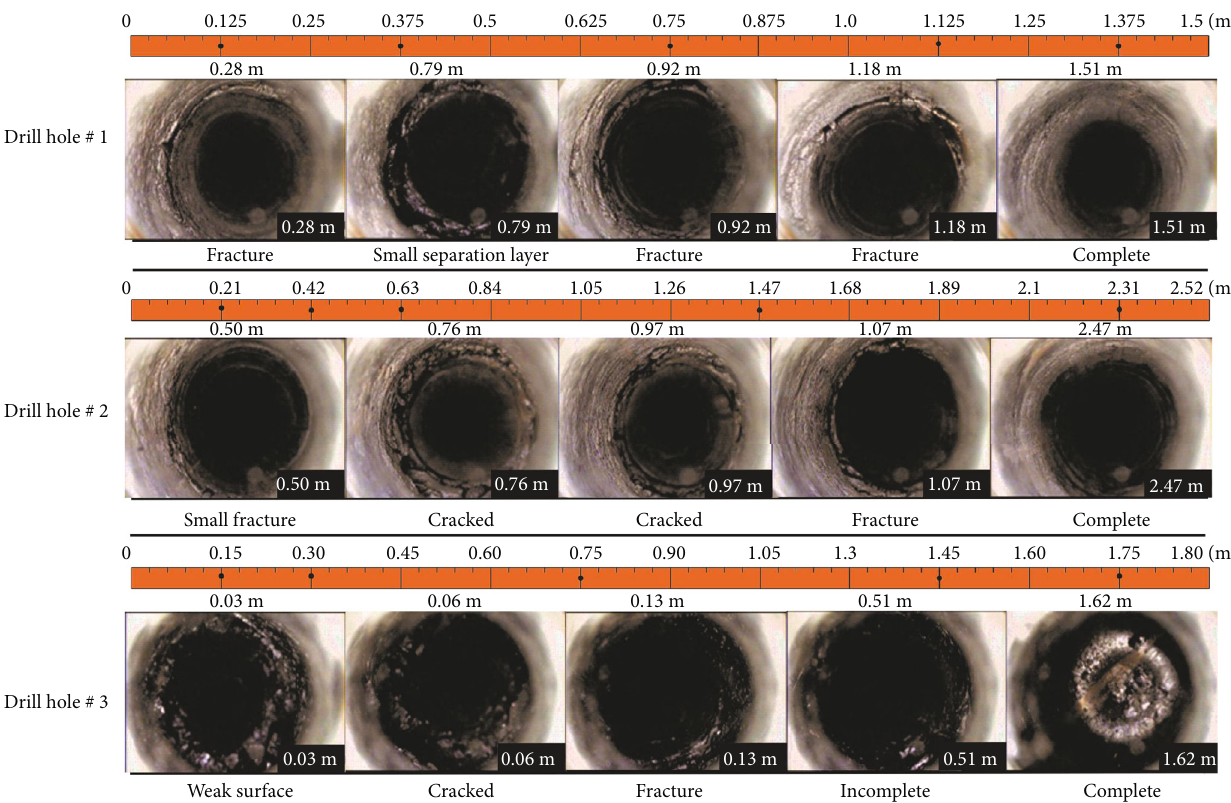
Figure 13: Fracture development of roadway surrounding